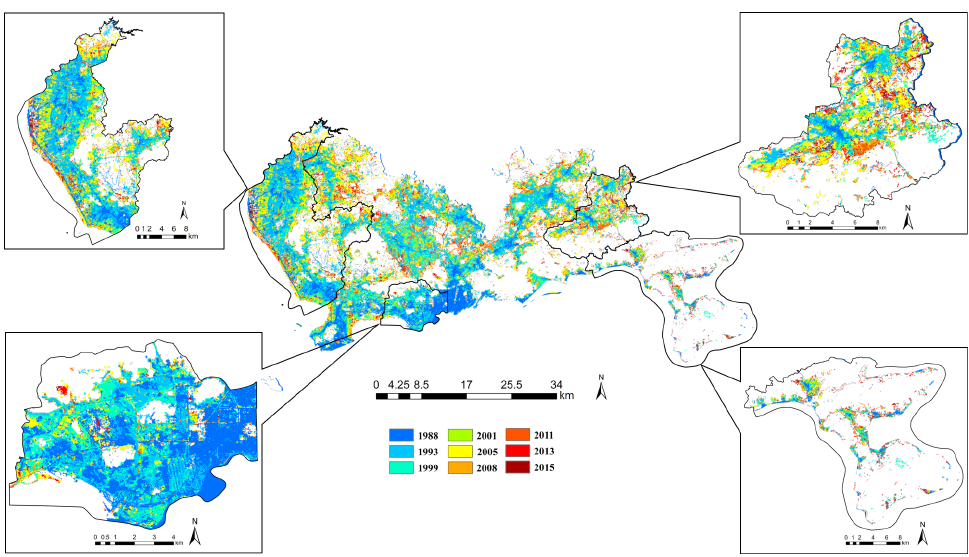
Figure 7. The diffusion process of built-up areas in different districts of